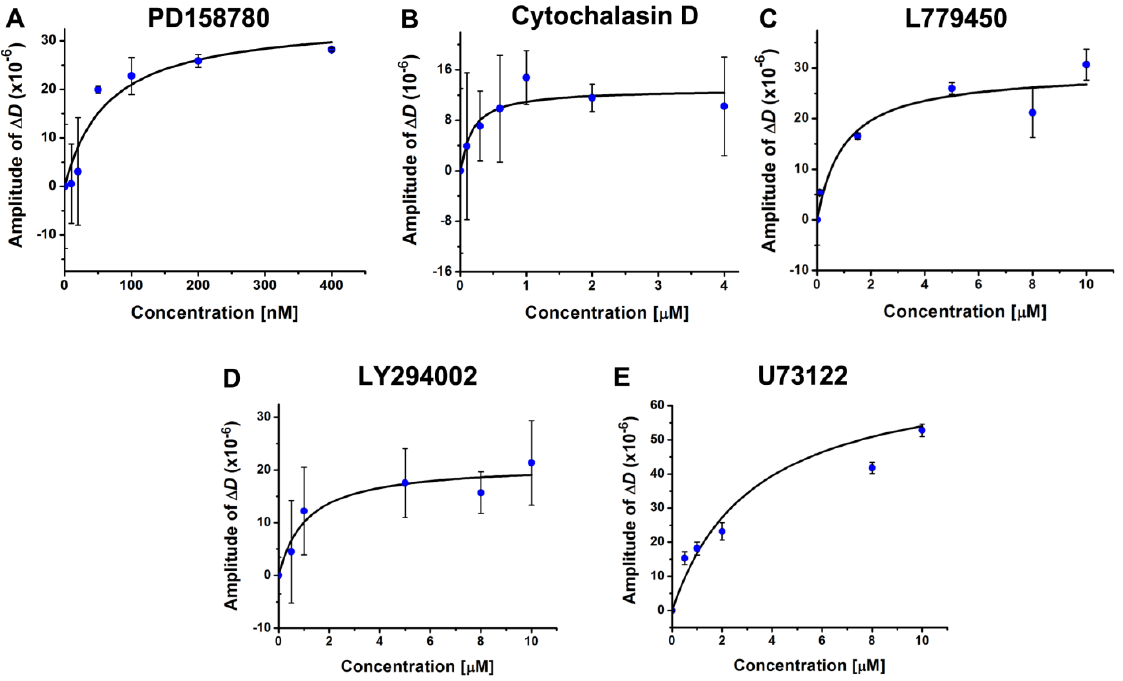
Figure 4. The amplitudes of EGF-induced Δ D -responses at 40 min as a function of inhibitor concentrations. The amplitude is defined as the absolute value of the difference between the experimental value and the control value. The data, derived from the average of at least three sets of independent data, was fit with the dose-response